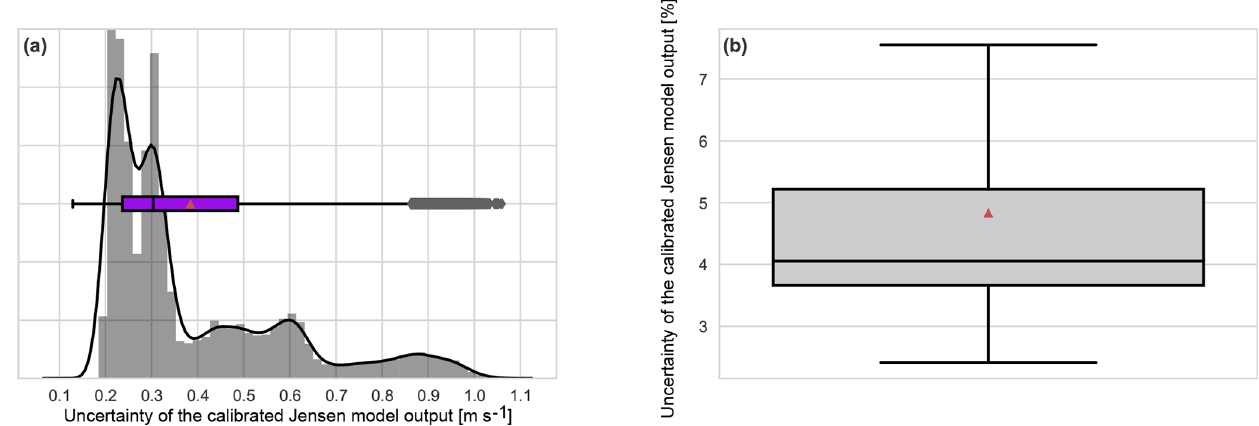
Figure 14. Distribution of the uncertainty in the estimated wake velocity by calibrated Jensen model, (a) the histogram and the boxplot of the distribution in units (ms − 1 ), (b) the boxplot of the percentage uncertainty distribution. The median, the boxes, the whiskers and the outliers are according to Tukey’s descriptive statistics (Tukey, 1962). The red triangles indicate the